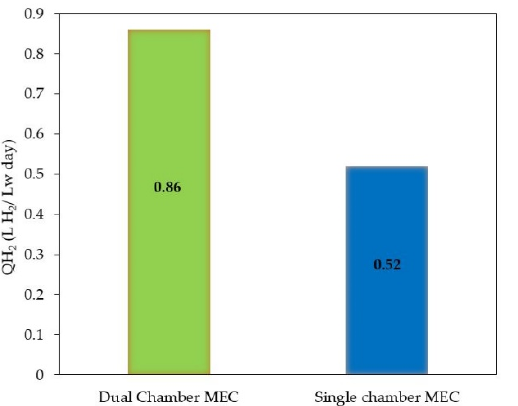
Figure 7. The comparison between single and dual chamber MEC regarding the generated hydrogen.